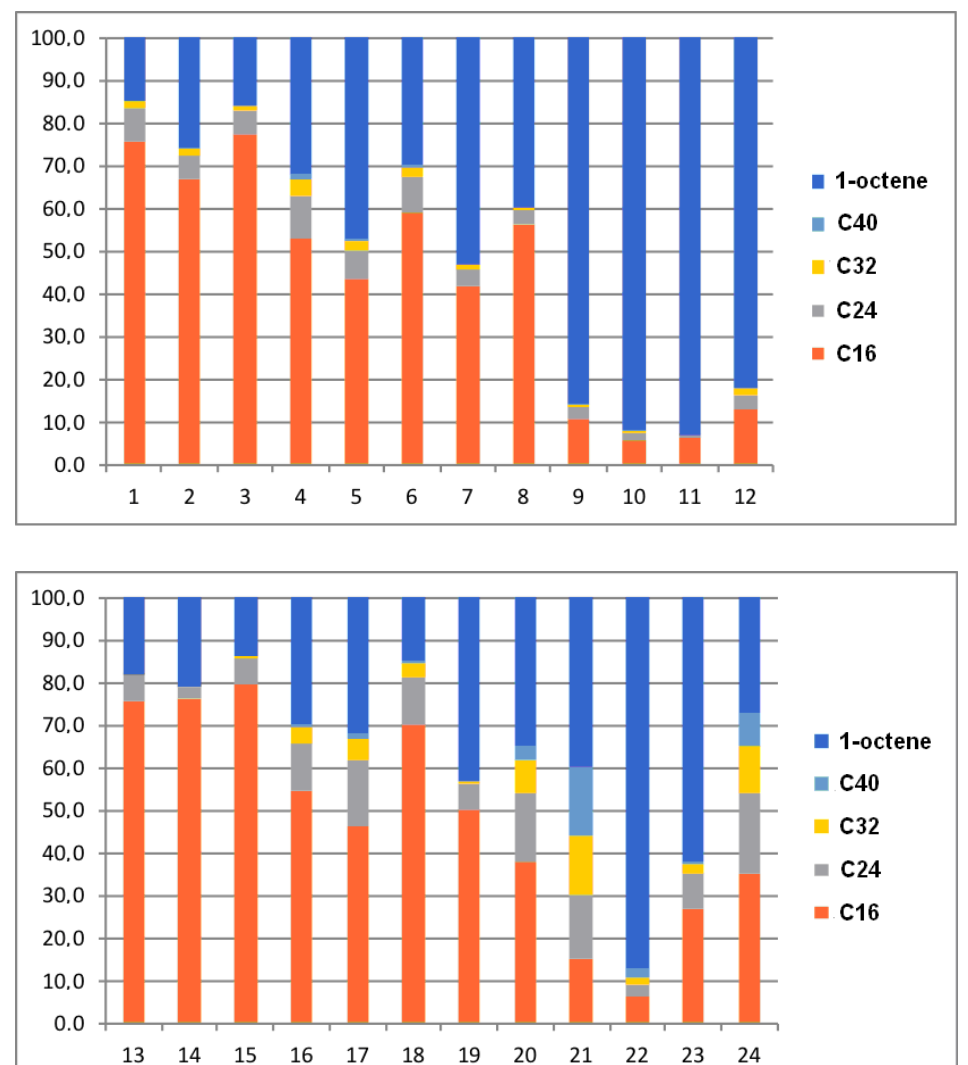
Figure 1. The weight distribution of the reaction products and unreacted 1-octene in bulk oligomerization, catalyzed by 1 / 1 ′ (top) and 2 / 2 ′ (bottom). Run numbers are given below the